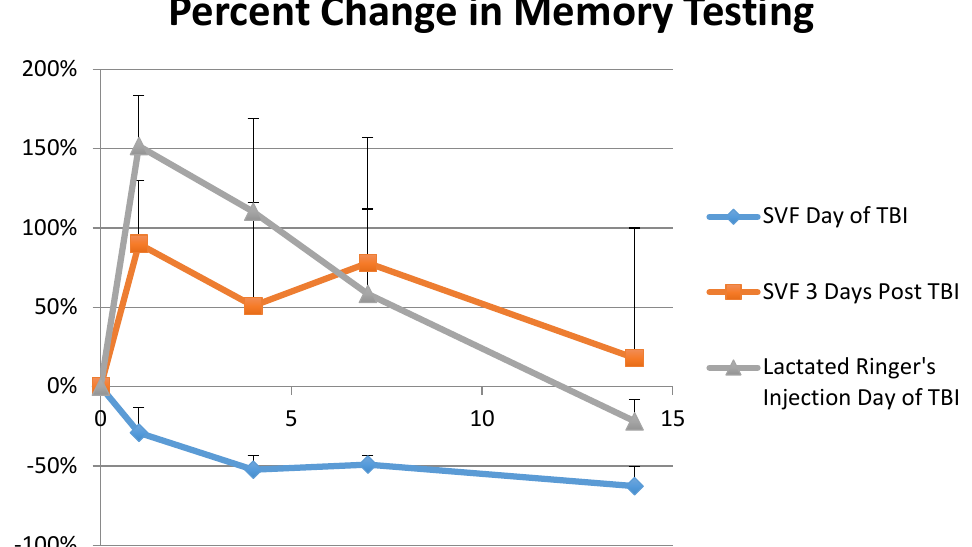
Figure 3. Percent Change in Memory shows a comparison between three groups: Group 1, which was treated with SVF the day of TBI and Group 3, which was treated with Lactated Ringer’s solution the day of TBI. The test was continued for 14 days. N = 6 per treatment. p < 0.01. Data from Group 2, rats treated with SVF 72 h post injury, is also included but not statistically significant.